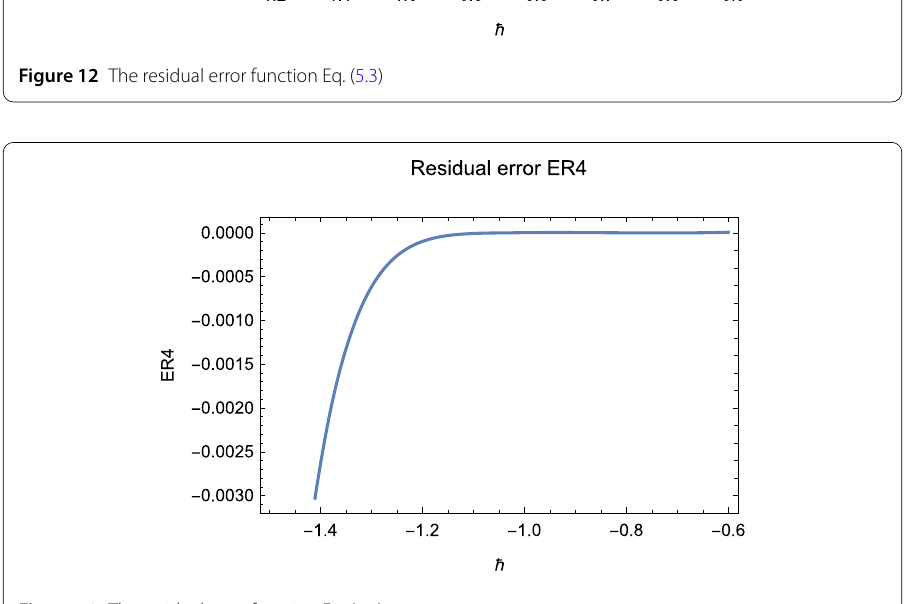
Figure 12 The residual error function Eq. (5.3)